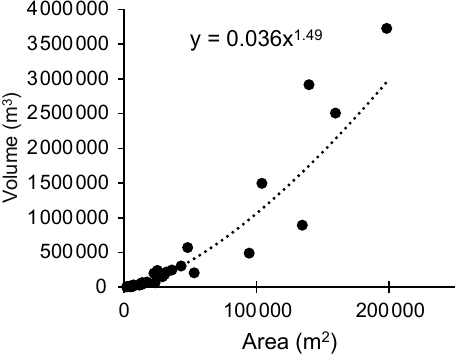
Figure 5. Relationship between lake area and volume in the Zaili- iskiy and Djungarskiy